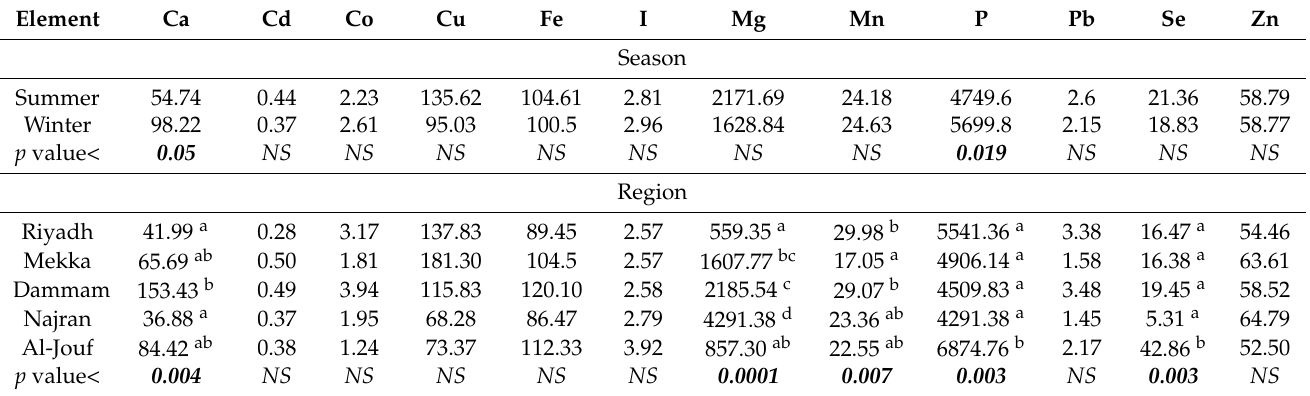
Table 5. Mean values of minerals in camel liver according to region and season [µg/g wet weight].